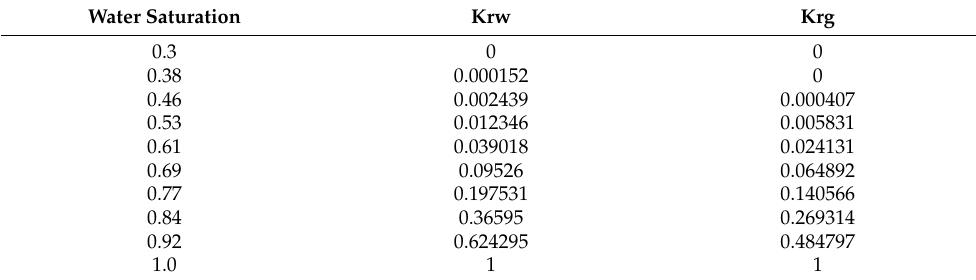
Table 2. Relative permeability for water and CO 2 .